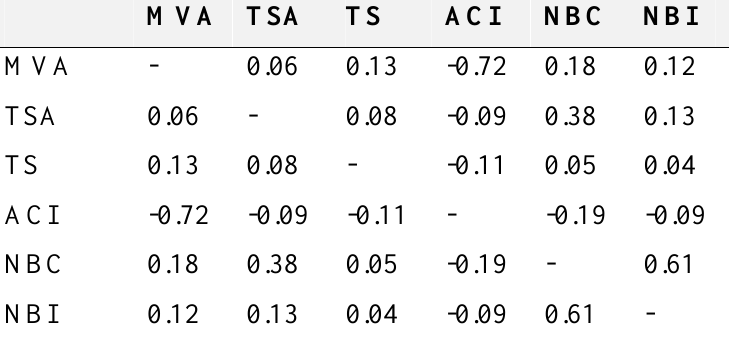
Table 4 – Correlation matrix: Spearman Correlation